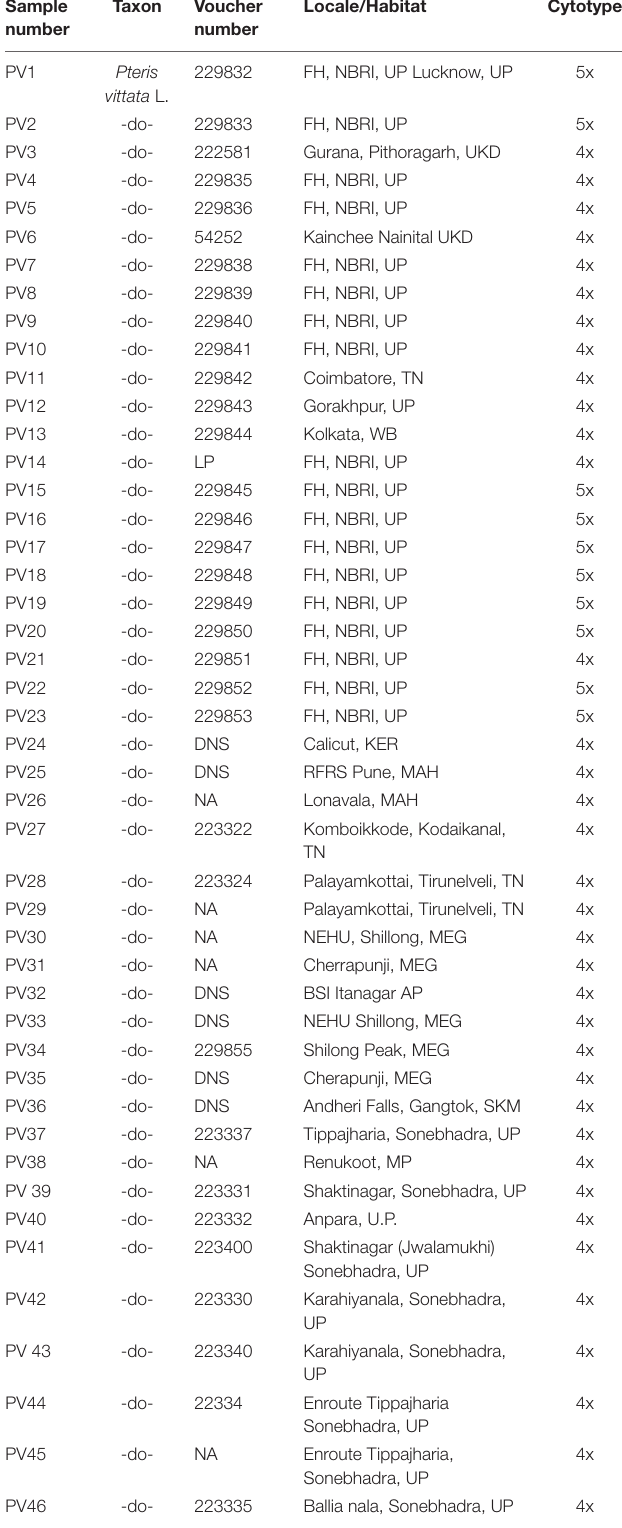
TABLE 1 | Pteris vittata and other Pteris species included for the studies on PCR-based profiling analysis are given below. Sample